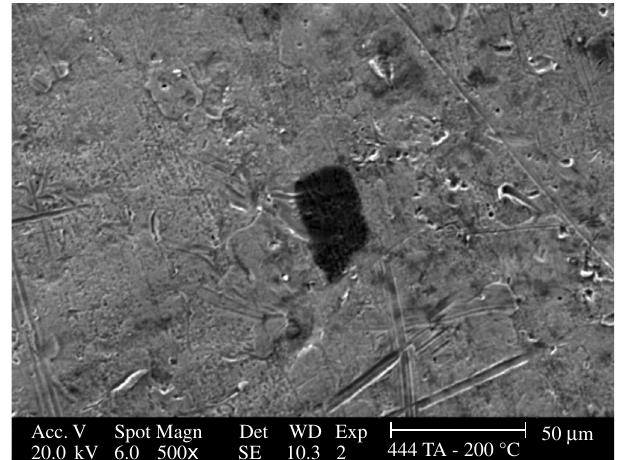
Figura 7. Oxide layer covering AISI 304 steel surface. Sample heat treated at 400 °C.